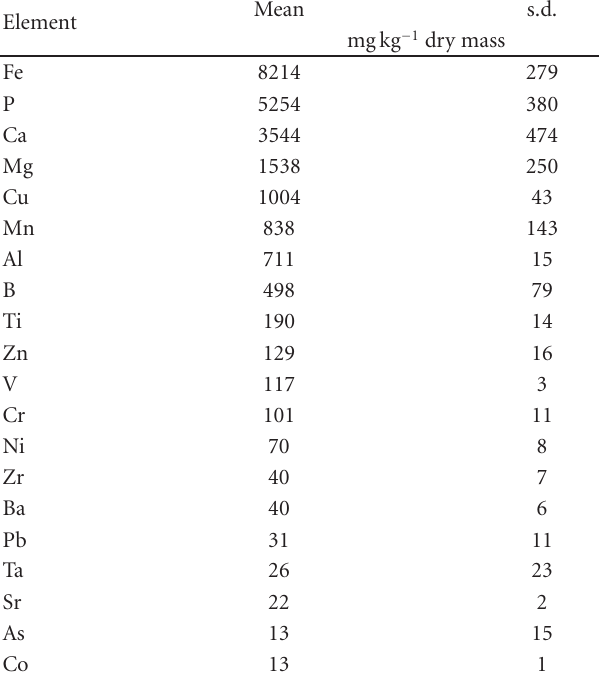
Table 2: Concentration in the sludge of the 20 elements exceeding 10mgkg − 1 in addition to C, H, O, N, K, and S. Means and standard deviations (s.d.) are for n =